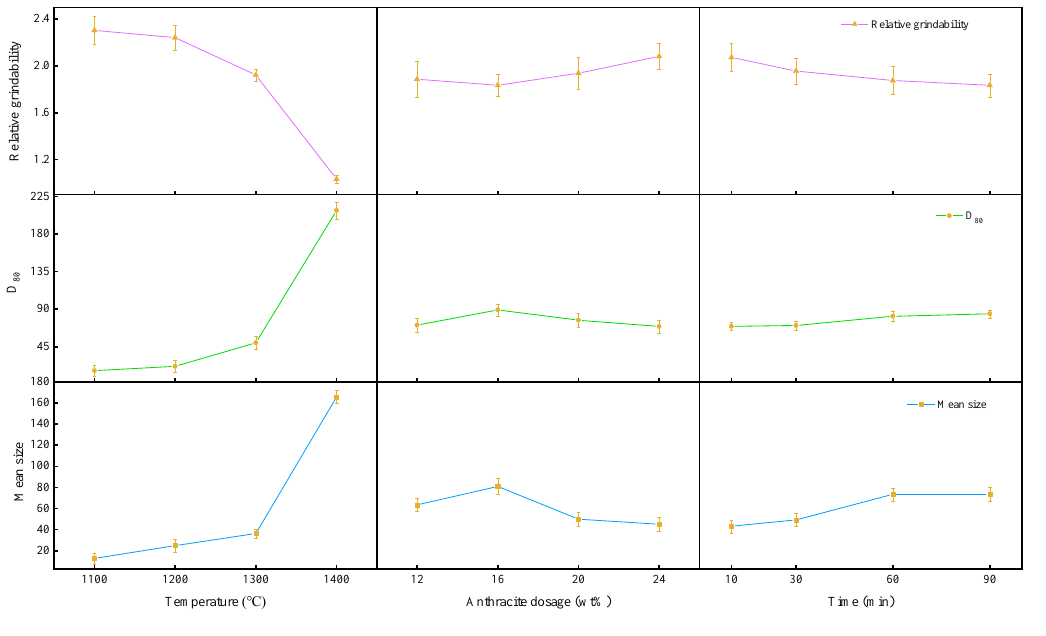
Figure 8. The average value at each level of each factor. Table 3. Range analysis of different evaluation indexes.